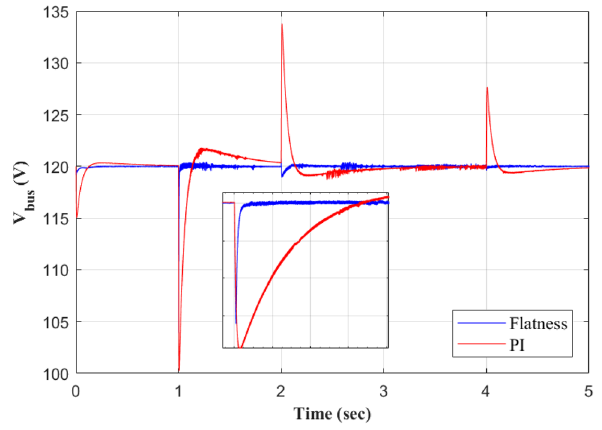
Fig. 11 DC bus voltage